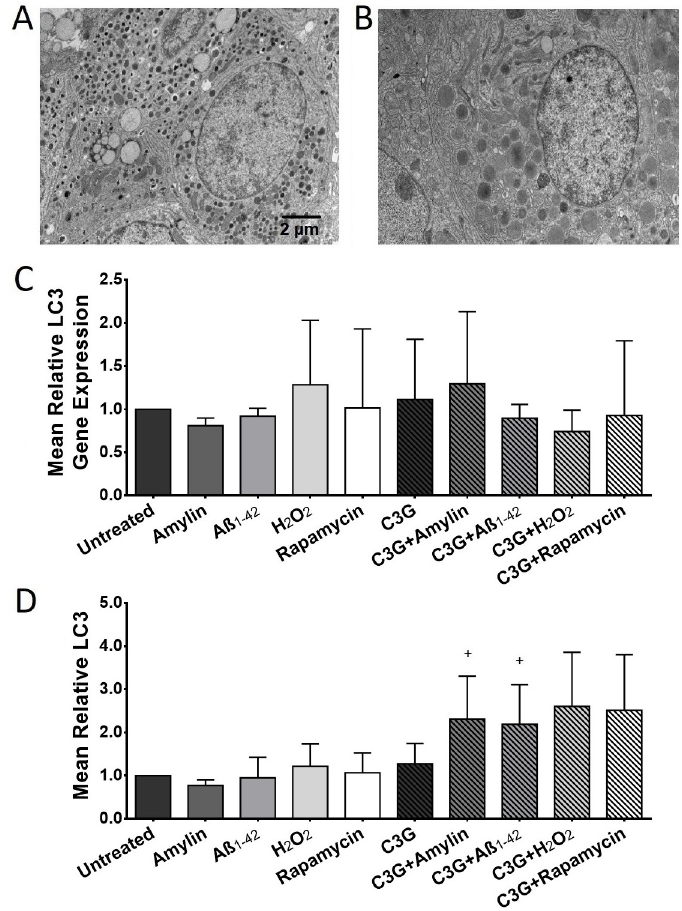
Fig 4. Effect of C3G on autophagy in human islets exposed to amylin, A β 1-42 , H 2 O 2 or rapamycin. (A) Representative TEM image of a β cell in untreated and (B) C3G-treated islets. Scale bar represents 2 μ m. (C) Mean relative autophagic vesicle marker LC3 gene expression in untreated or C3G-treated human islets exposed to amylin or A β 1-42 (n = 4). (D) Mean relative LC3 protein expression in untreated and C3G-treated human islets exposed to amylin or A β 1-42 ( + p < 0.05, amylin vs. C3G + amylin; + p < 0.01, A β 1-42 vs. C3G + A β 1-42 ; n = 3–5). (1.22 ± 0.52, n = 3, Fig 4D) compared to the untreated islets. This trend was also observed in C3G-treated islets that were exposed to H O , (2.60 ± 1.26, n = 3) when compared with islets 2 2 treated with H O only. Treatment of islets with C3G and rapamycin increased the levels of 2 2 LC3 detected (2.51 ± 1.29, n = 3) compared to the rapamycin-treated islets (1.07 ± 0.46, n = 3). C3G decreased the protein expression of inflammatory markers in human islets The effect of C3G on islet inflammation was also evaluated. Islets exposed to amylin or A β 1-42 showed significantly higher protein expression of NLRP3 inflammasome (1.81 ± 0.35 and 1.47 ± 0.42, n = 5, respectively, Fig 5A) compared to the untreated islets (1.00 ± 0.00, n = 5). Like- wise, the NLRP3 protein expression observed in islets that were exposed to H O or rapamycin 2 2 was also increased (1.47 ± 0.07 and 1.36 ± 0.14, n = 3, respectively) compared to the untreated islets. C3G-treated islets that were exposed to amylin (0.91 ± 0.21, n = 5) or A β (0.80 ± 0.13, 1-42 n = 4) showed significantly less NLRP3 compared to the islets exposed to amylin or A β 1-42